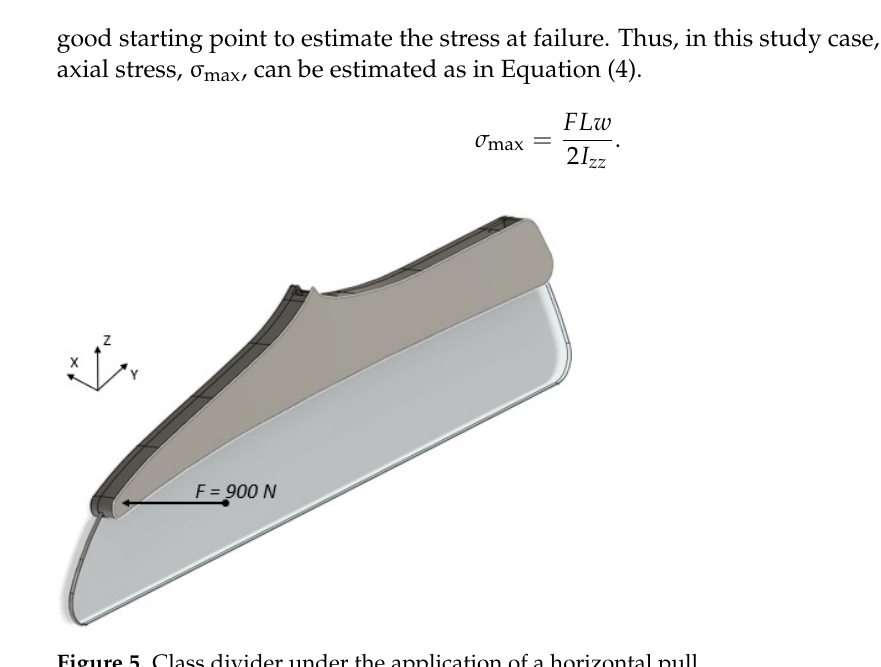
Figure 5. Class divider under the application of a horizontal pull.